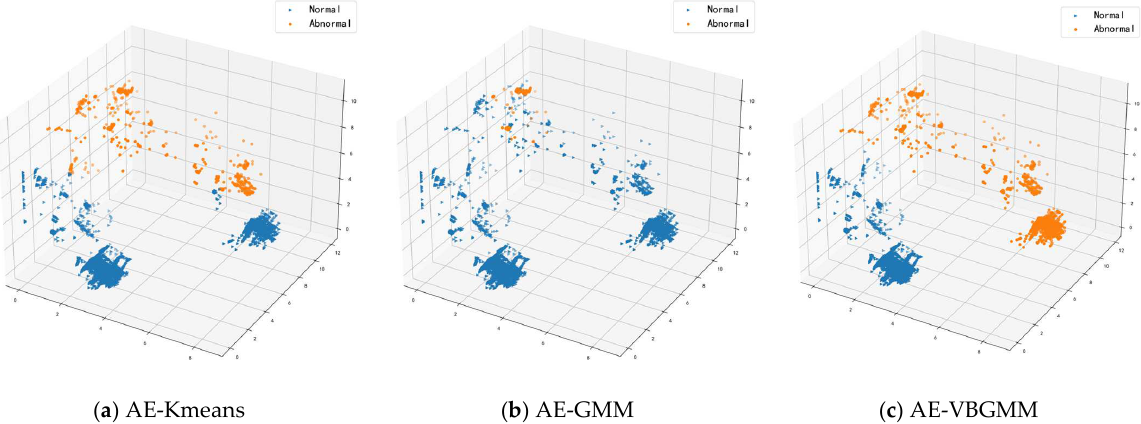
Figure 6. Anomaly detection of normal data benign and abnormal data httpflooding by AE-Kmeans,